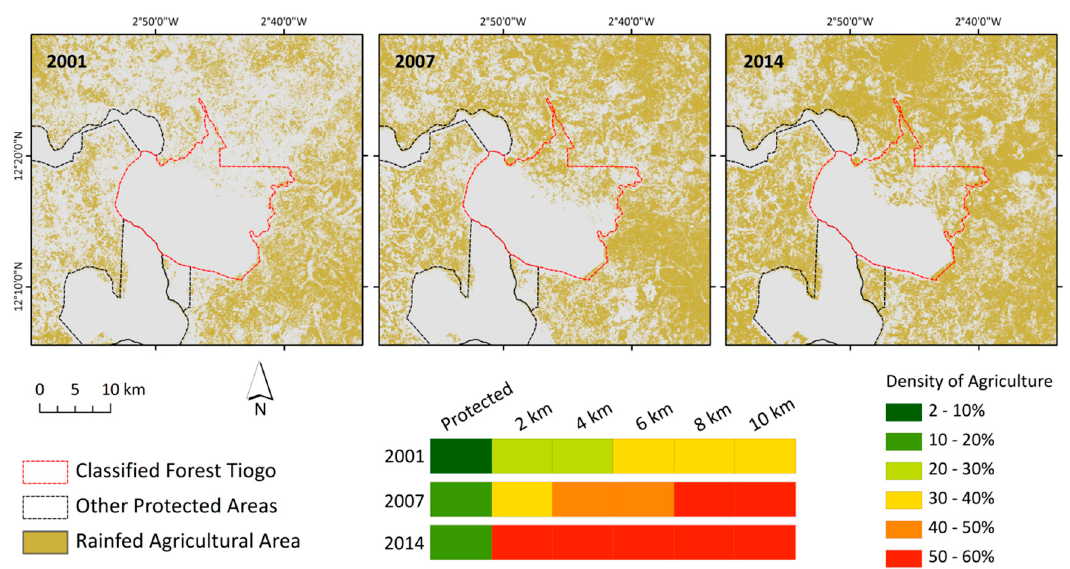
Figure 13. Maps of agricultural area in the classified forest Tiogo and its surroundings for 2001, 2007, and 2014 ( top ) and plot of the development of agricultural area in the protected area and in 2 km distance zones around it between 2001 and 2014 ( bottom ); Location of focus area within Burkina Faso is marked in Figure 3.